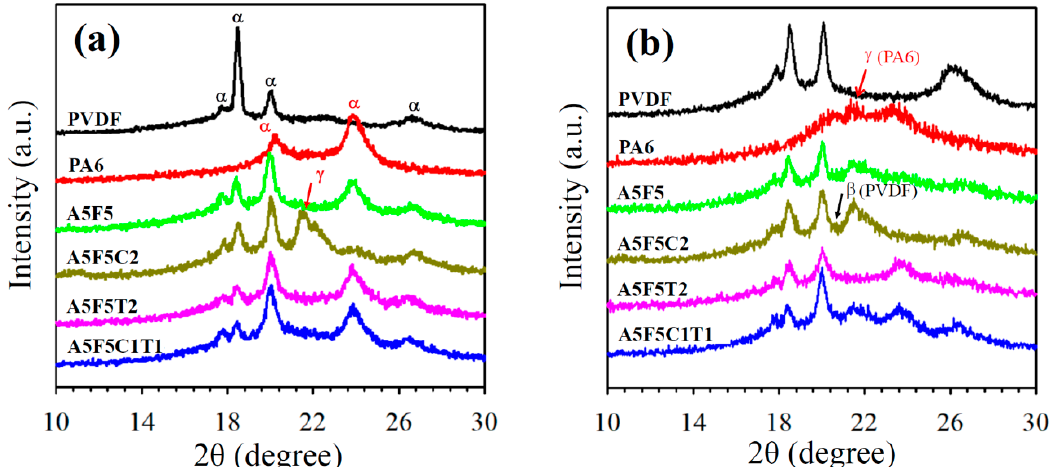
Figure 3. XRD patterns of selected samples prepared through different cooling rates: ( a ) 10 °C/min and ( b ) air quenching.